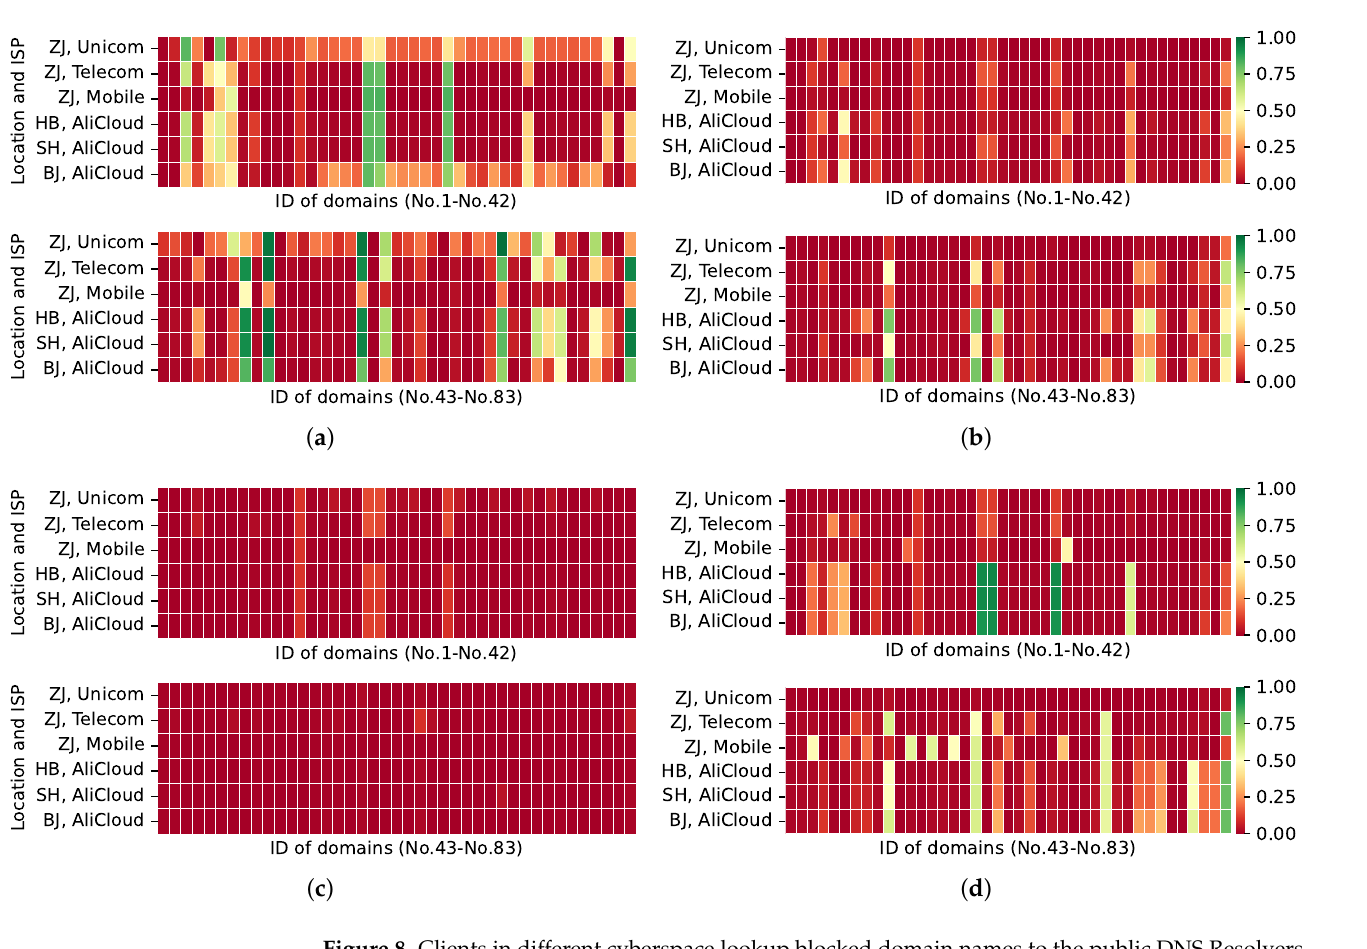
Figure 8. Clients in different cyberspace lookup blocked domain names to the public DNS Resolvers. ( a ) 180.76.76.76; ( b ) 117.50.11.11; ( c ) 119.29.29.29; ( d )